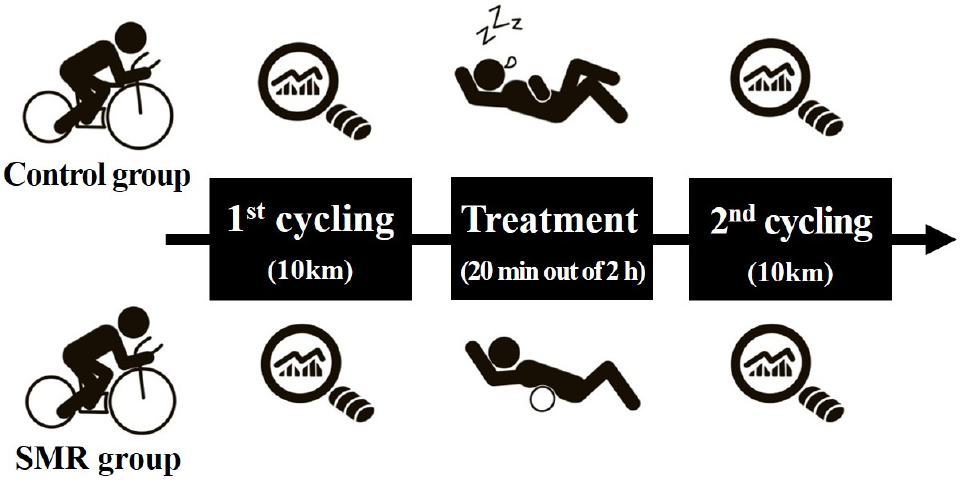
Figure 1. Schematic design of experimental